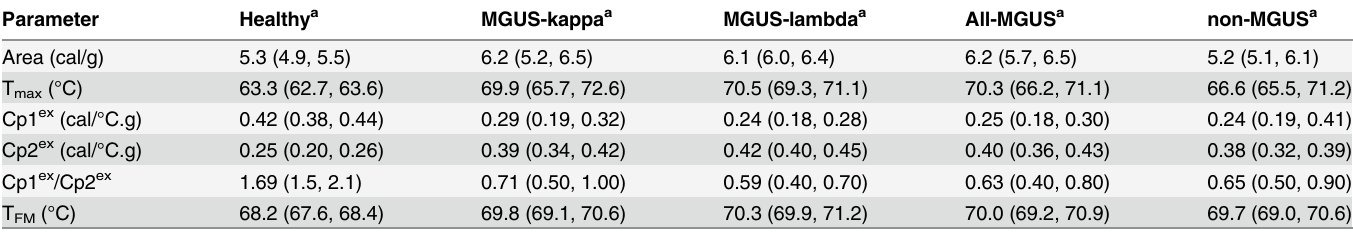
Table 2. Thermogram feature parameters of each clinical group, including “ healthy ” and non-MGUS sera controls.